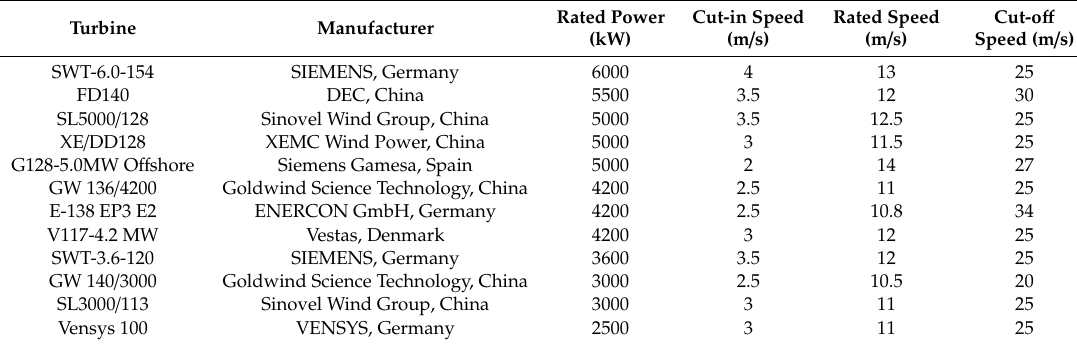
Table 2. Manufacturer-provided turbine curve